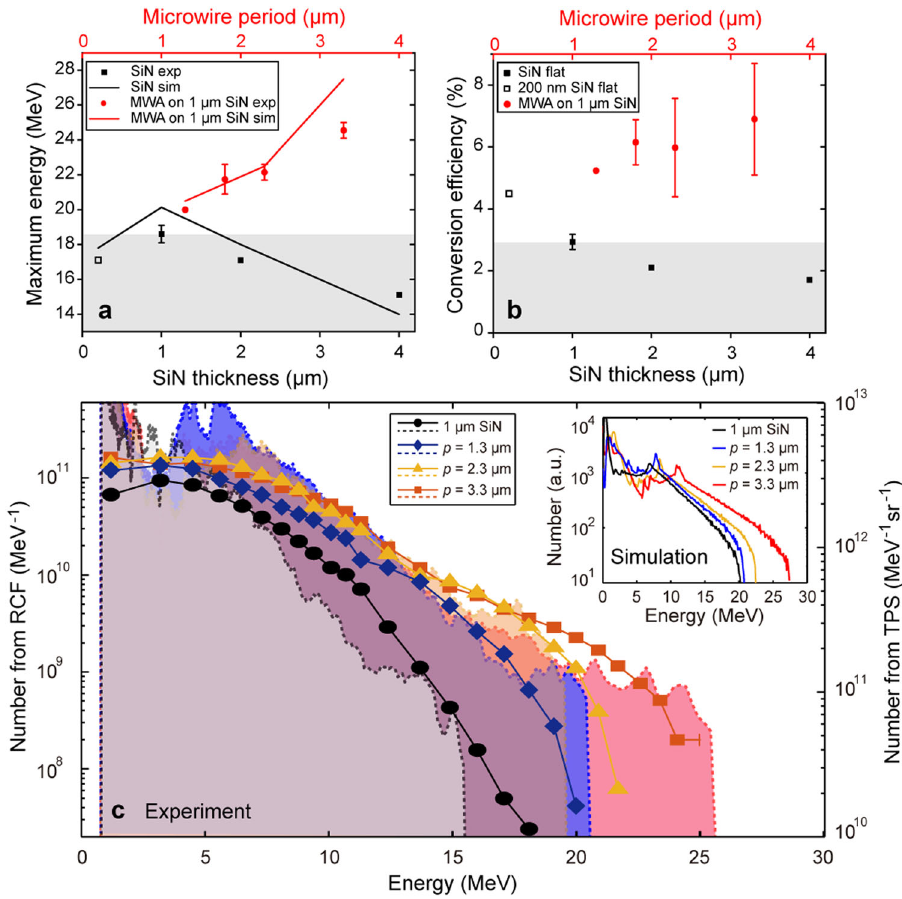
Fig. 2 Results of experiment and interpreting simulations. Cut-off proton energy ( a ) and energy conversion ef fi ciency ( b ) as a function of the thickness of planar SiN foils (black) and the spatial period of microwire array (MWA) targets (red), from experiments (solid dots) and simulations (solid lines). The conversion ef fi ciency from laser to protons (kinetic energy > 1 MeV) is obtained from the radiochromic fi lm (RCF). Here the high conversion ef fi ciency for 0.2 μ m results from more complicated mechanisms thus is excluded from comparison. The error bars are de fi ned by standard deviation from the mean of different shots. It should be noted that the calculation of conversion ef fi ciency takes into account the laser energy measured in each shot. The light-gray shadings represent the scope of cutoff energy or conversion ef fi ciency that planar targets involve. c Proton spectra obtained from RCF stacks (scattered points) and Thomson parabola spectrometer (TPS, dashed lines) for 1 μ m SiN foils, and MWA targets with three periods of 1.3, 2.3, and 3.3 μ m, respectively. The horizontal error bar marked for p = 3.3 μ m as the last sheet of RCF stack changed color in this shot. The inset of ( c ) is the simulated proton